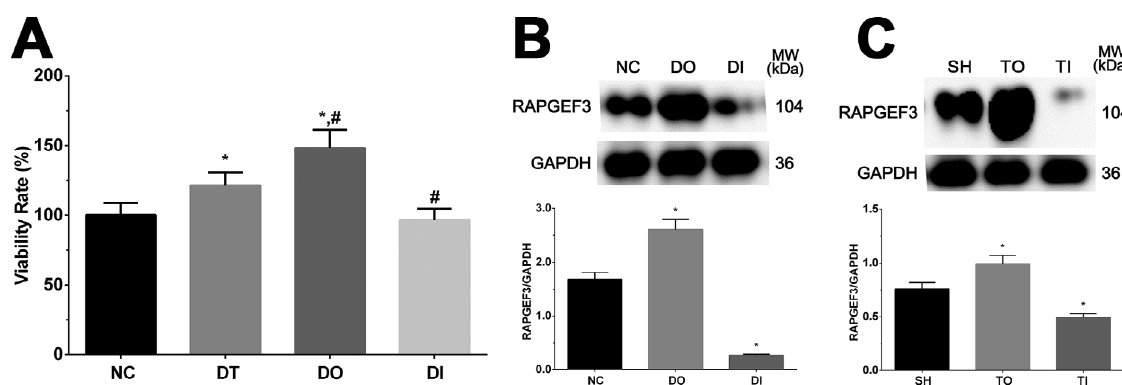
Figure 1 – Viability rate of glial cells in NC, DT, DO and DI group. (A) Viability rate of glial cells. (B) Expression of RAPGEF3 in NC, DO and DI group of glial cells without treatment of dezocine. (C) Expression of RAPGEF3 in SH, TO and TI group of rats model without treatment of dezocine. Data was presented as mean ± SD, each experiment was repeated for three times. *P<0.05 vs NC group of cells or SH group of rats. #P<0.05 vs signal dezocine treatment group. NC: normal group, DT: dezocine treatment group, DO: dezocine treatment combined with RAPGEF3 overexpression group, DI: dezocine treatment combined with RAPGEF3 inhibition group. SH: sham group, TD: dezocine treatment group, TO: dezocine treatment combined with RAPGEF3 overexpression group, TI: dezocine treatment combined with RAPGEF3 inhibition